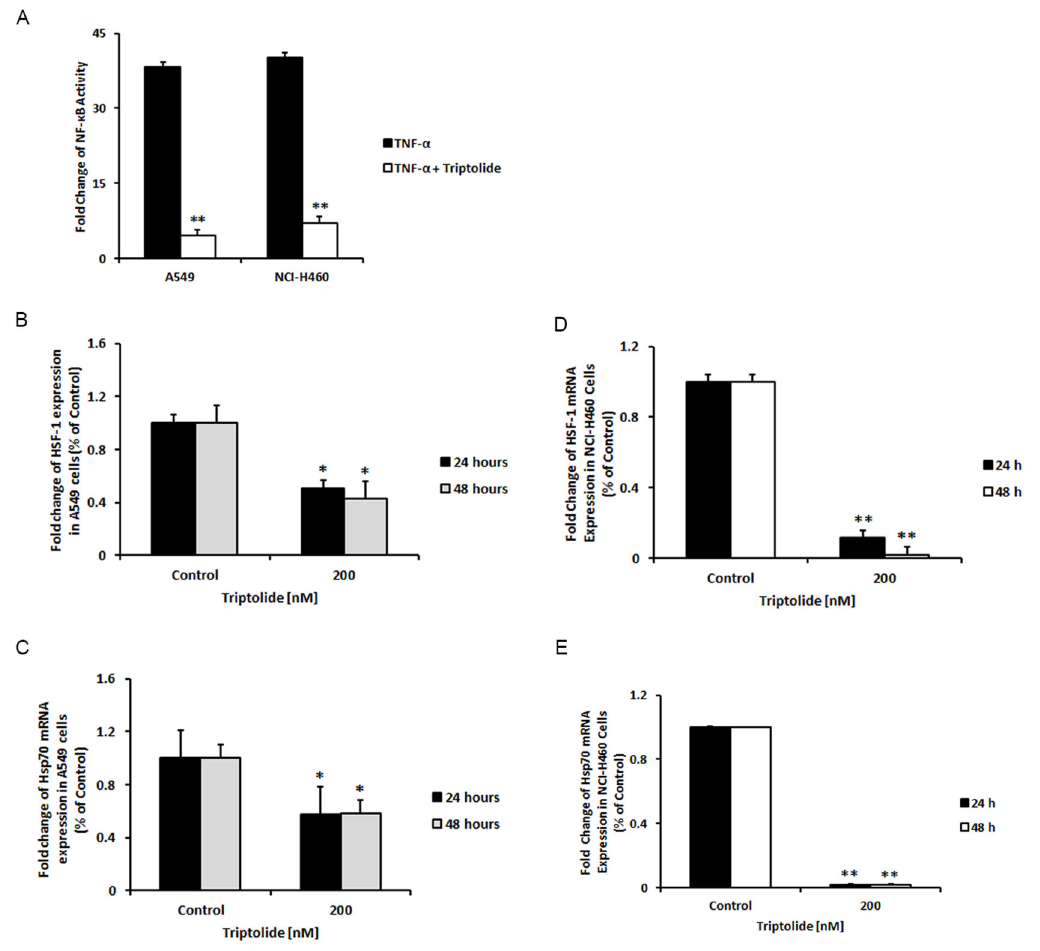
Figure 4. Triptolide inhibits NF-κB signaling pathway and its transcriptional activity of its target genes. NF-κB activity was assessed using dual-luciferase reporter assay after 24-hour treatment with TNF-α (20 ng/ml) or TNF-α (20 ng/ml) in combination with 100 nM of triptolide. The NF-κB activity was stimulated in the cells treated only with TNF-α, while it was effectively decreased after 100 nM of triptolide in A549 and NCI-H460 cells (A). Levels of HSF-1 and Hsp70 mRNA expressions were significantly down- regulated in A549 (B and C) and NCI-H460 cells (D and E). Columns , mean, bars , SE. Statistical significance of results was calculated with the Student`s t test (N=3) * P = 0.05; ** P = 0.005.